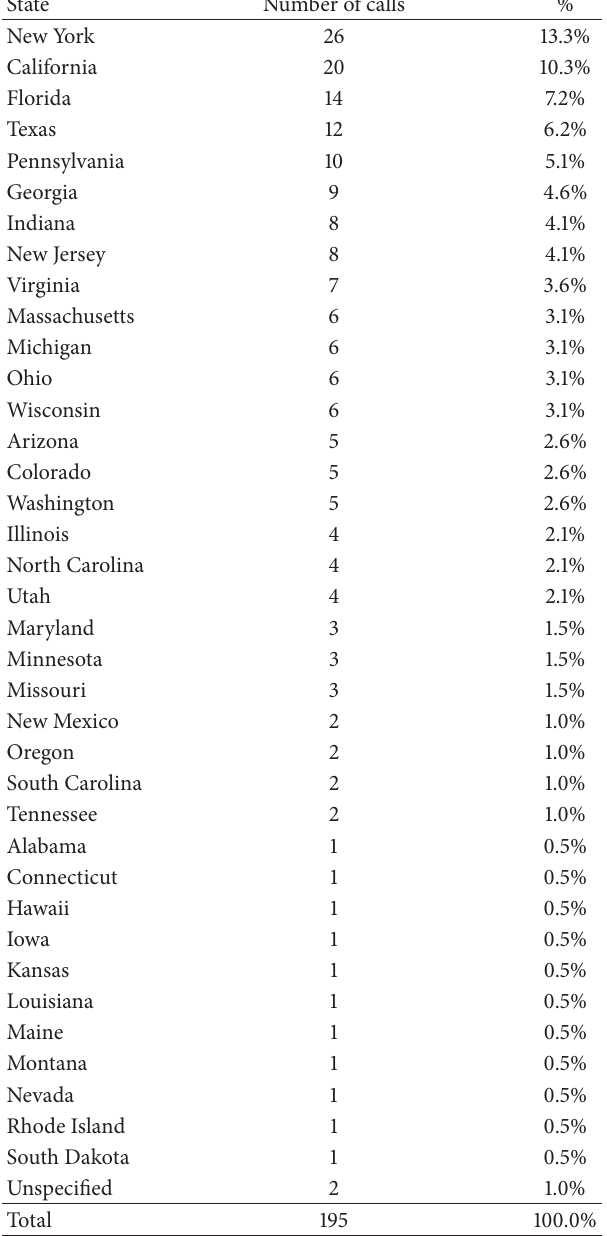
Table 1: Geographic distribution of the callers from